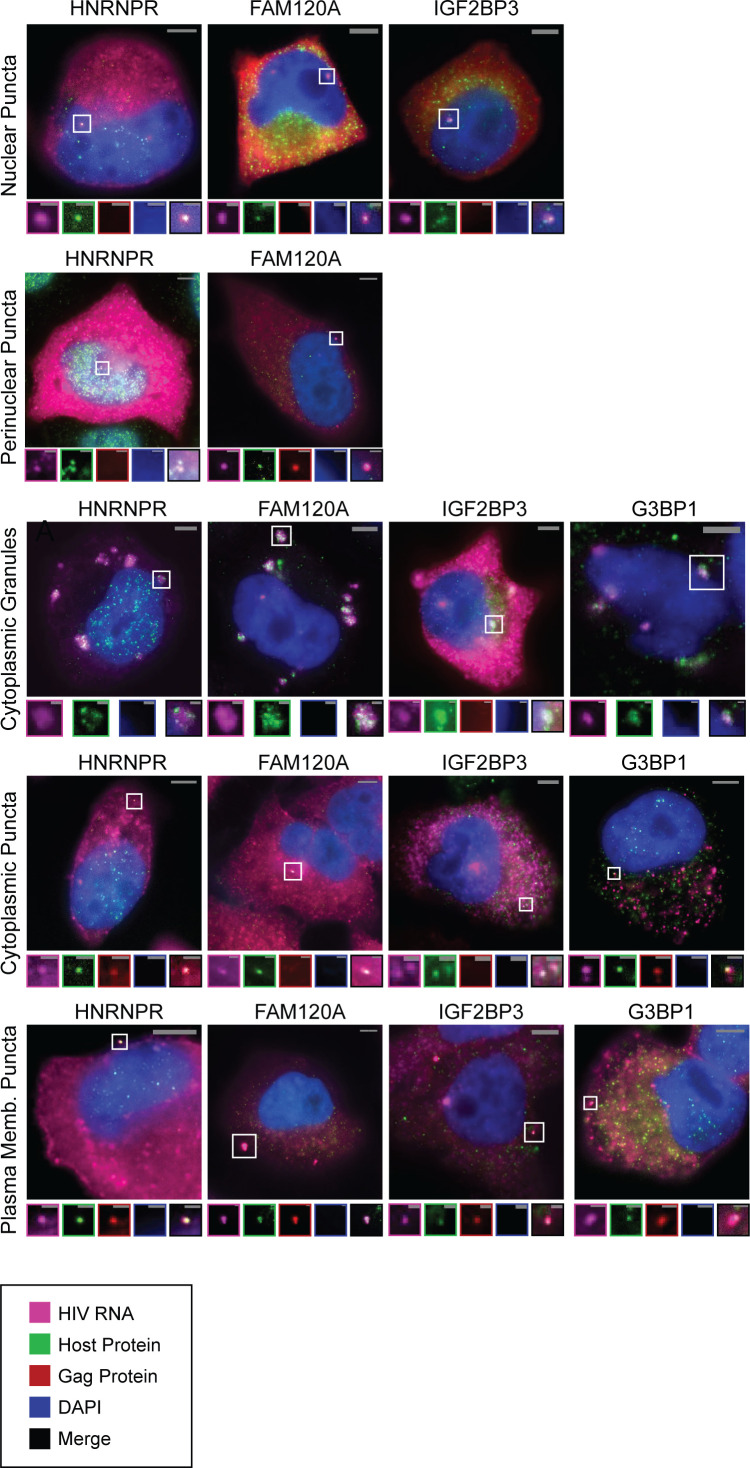
Representative images of host proteins co-localizing with unspliced (US) HIV RNA.Analysis of host proteins (HNRNPR, FAM120A, IGF2BP3) that co-localize with US HIV RNA at cytoplasmic granules. HNRNPR primarily localizes to the nucleus while FAM120A and IGF2BP3 primarily localize to the cytoplasm. All three were observed to co-localize to transcription sites; however, only HNRNPR did so frequently (80% vs 8% and 4%, respectively; Figure 4B). All three co-localize with HIV RNA to cytoplasmic granules, cytoplasmic puncta, and plasma membrane puncta. We assayed, G3BP1, a known component of stress granules, and found it also co-localized with US RNA in these three cytoplasmic locations. An additional image of a large cytoplasmic granule is included for G3BP1 showing a spiral-like phenotype of small puncta around the granule at which US HIV RNA and G3BP1 also co-localize.